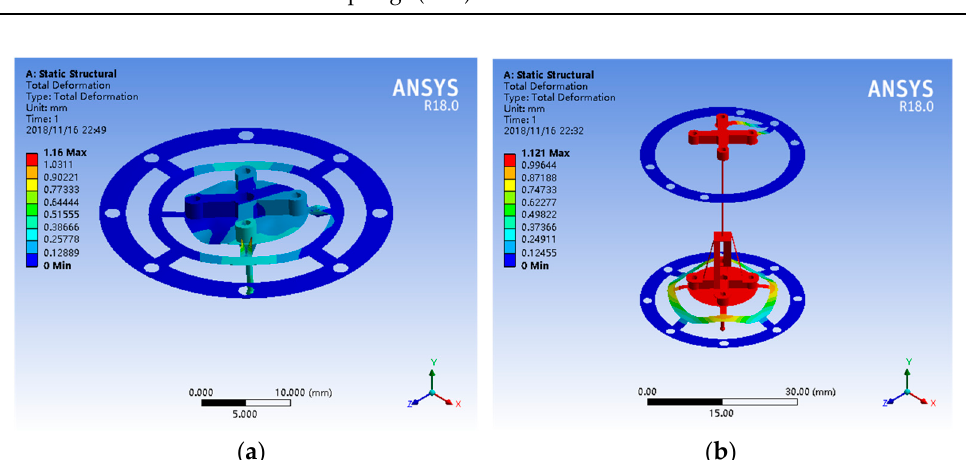
Figure 5. Simulation results when a 1 mN force is applied to the probe tip: ( a ) in horizontal; ( b ) in vertical.